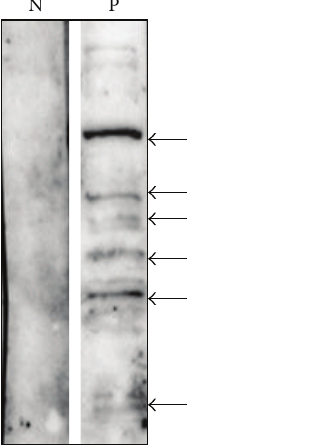
Figure 4: Protein extracts prepared from melanoma cell lines were separated by 10% SDS-PAGE (50 𝜇 g/lane), transferred to nitrocellu- lose, and then incubated with patient serum (P) obtained at week 28 after immunisation. Immunoreactive proteins were detected using HRP-conjugated anti-human IgG. As a control, a serum from a normal donor (N) was used. Reactive proteins are indicated by the